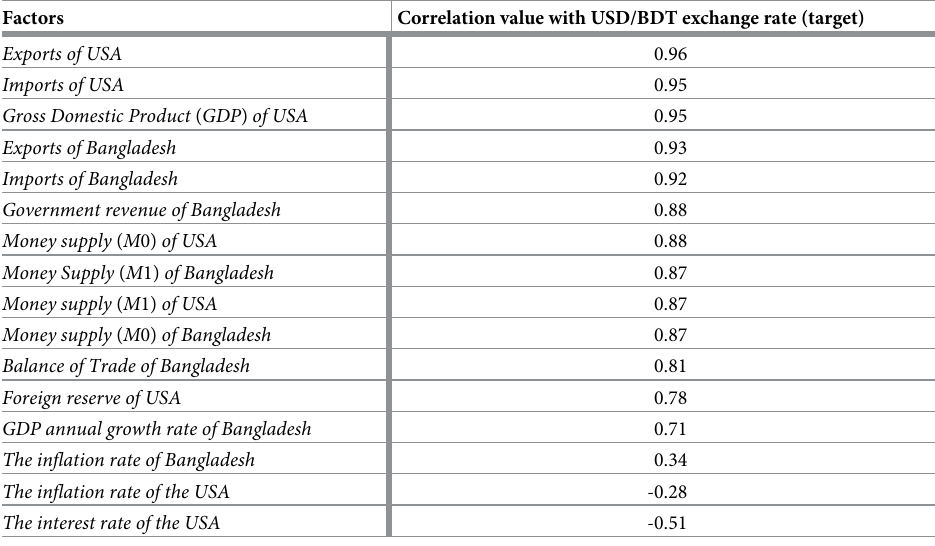
Table 1. Correlation (Pearson) between features(factors) and target.